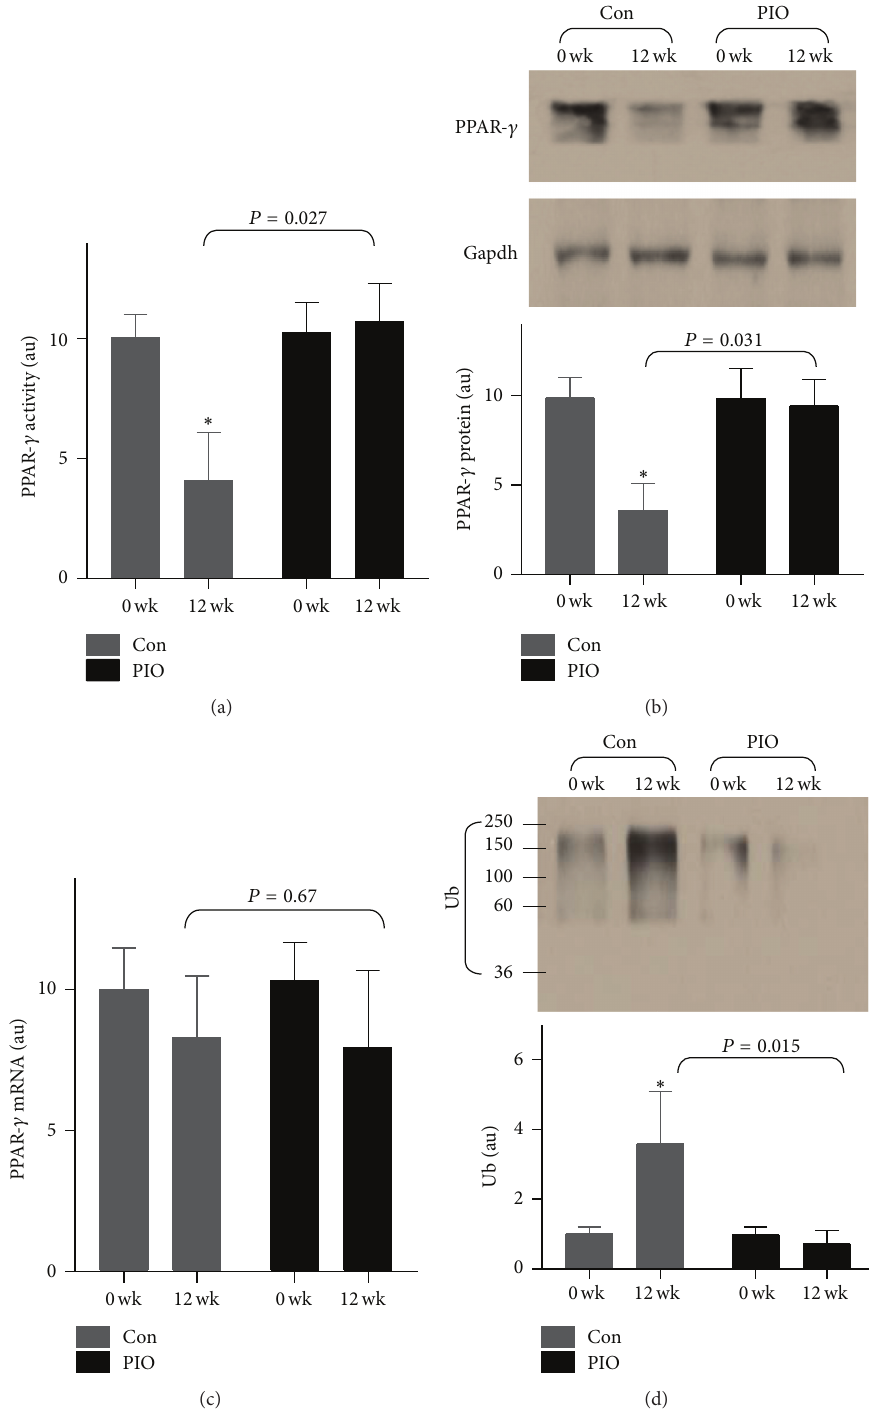
Figure 3: Pioglitazone blocked the DES-induced PPAR- 𝛾 ubiquitination and degradation in vivo. (a) PPAR- 𝛾 DNA binding activity was shown. (b) PPAR- 𝛾 protein was tested by Western blot. (c) The mRNA expression of PPAR- 𝛾 . (d) The ubiquitination of PPAR- 𝛾 was detected by coimmunoprecipitation assay. ∗ 𝑃 < 0.05 , compared with